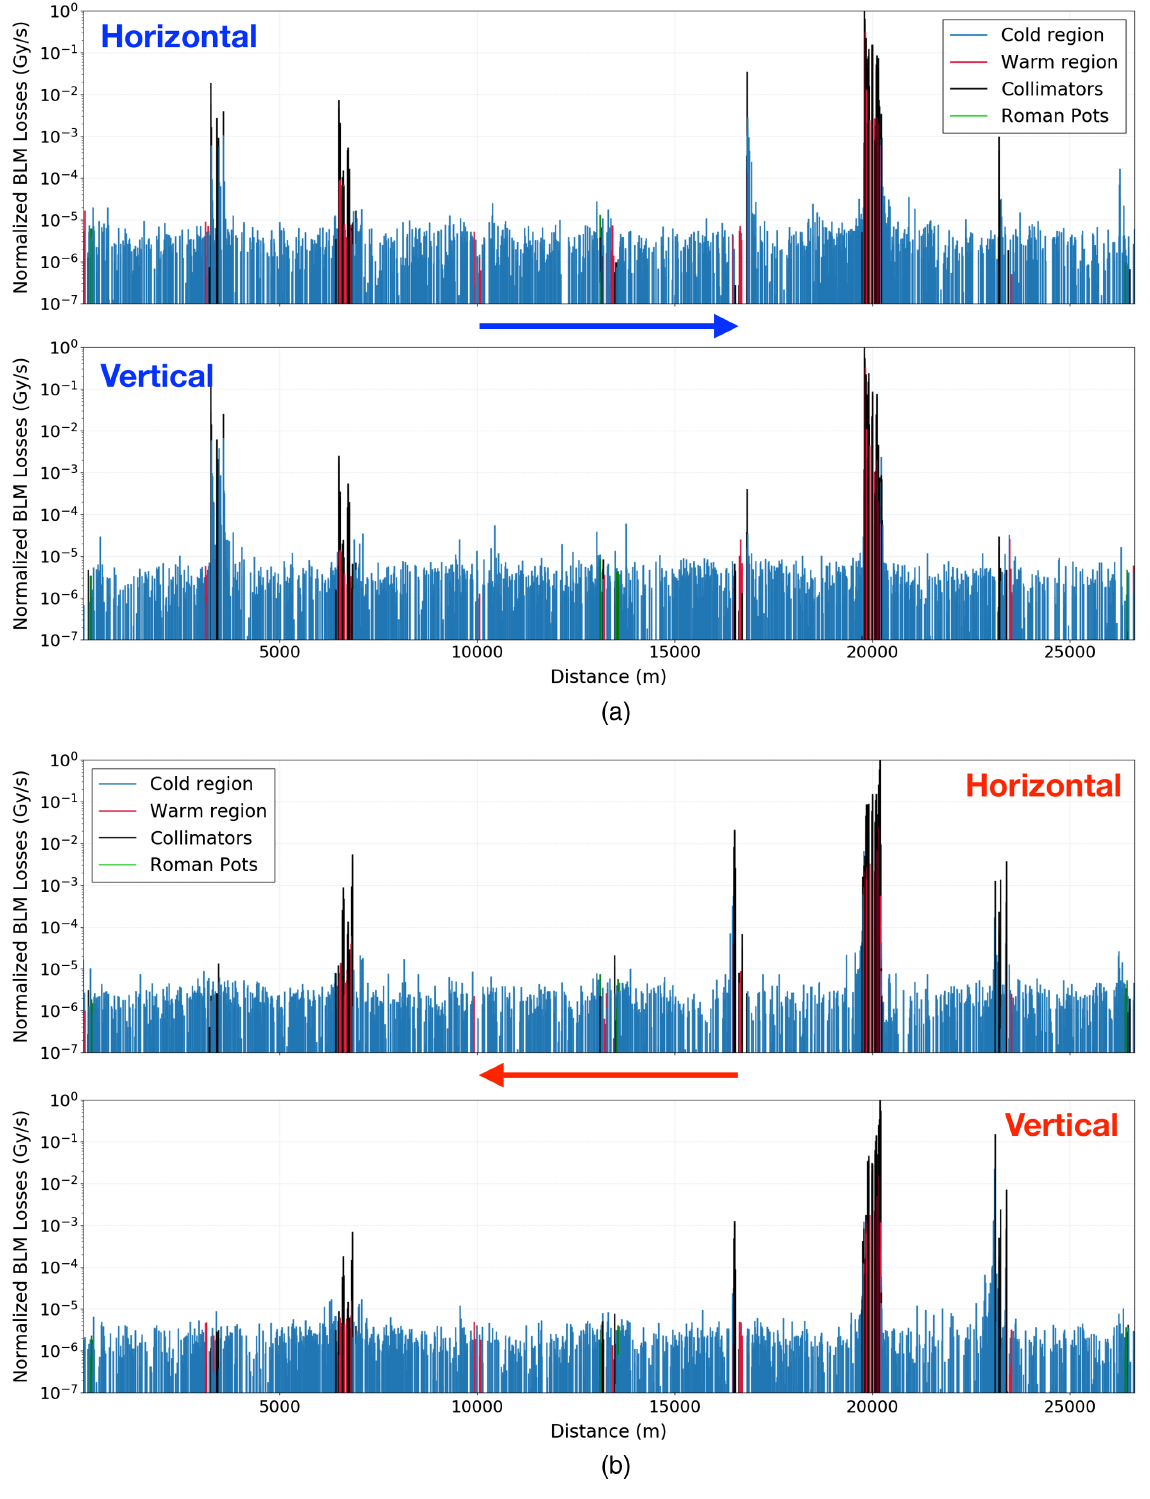
FIG. 18. Loss maps generated on 13-04-2018 to validate the BLM collimator alignment at injection for (a) beam 1, and (b) beam 2, indicating the beam direction by the arrow in each